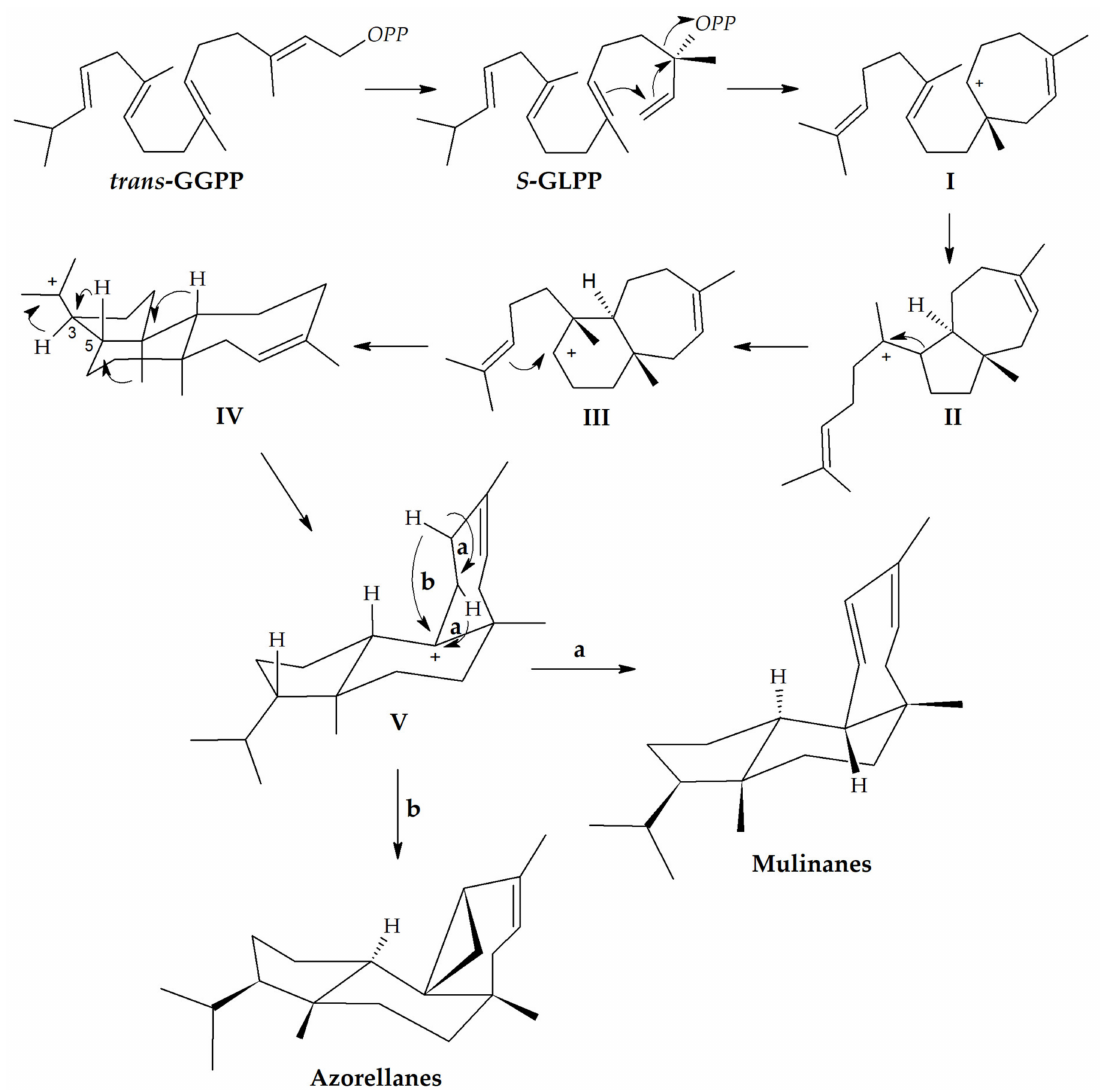
Figure 2. Biosynthetic pathway to mulinane and azorellane diterpenoid skeletons. GGPP: geranylgeranyl pyrophosphate; S -GLPP: S -geranyllinaloyl pyrophosphate; OPP: Pyrophosphate